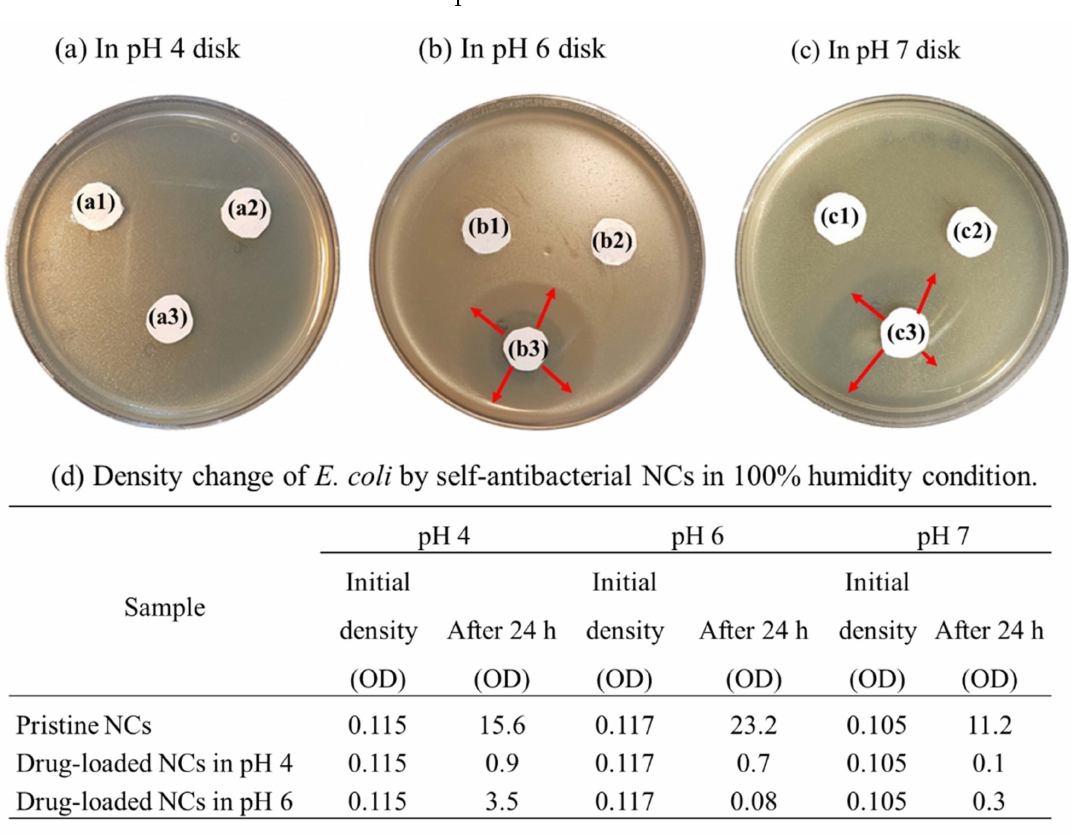
Figure 8. Self-antibacterial activity of ligand brush NCs at different pH conditions with 45% humidity of ( a – c ) pH 4, 6, 7 disks: ( a1 , b1 , c1 ) control sample, ( a2 , b2 , c2 ) pristine NCs, ( a3 , b3 , c3 ) drug-loaded NCs in pH 4, 6, 7; ( d ) density change of Escherichia coli